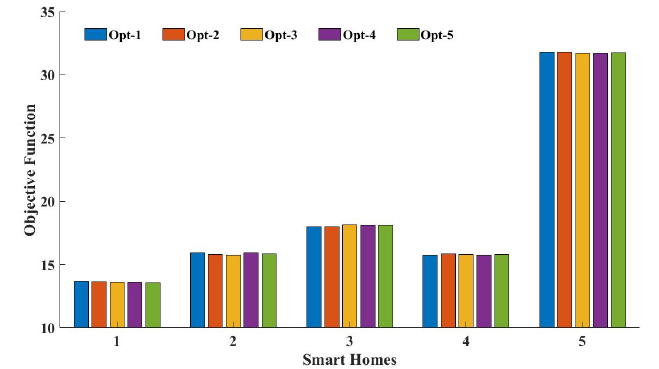
Figure 4. GA optimization